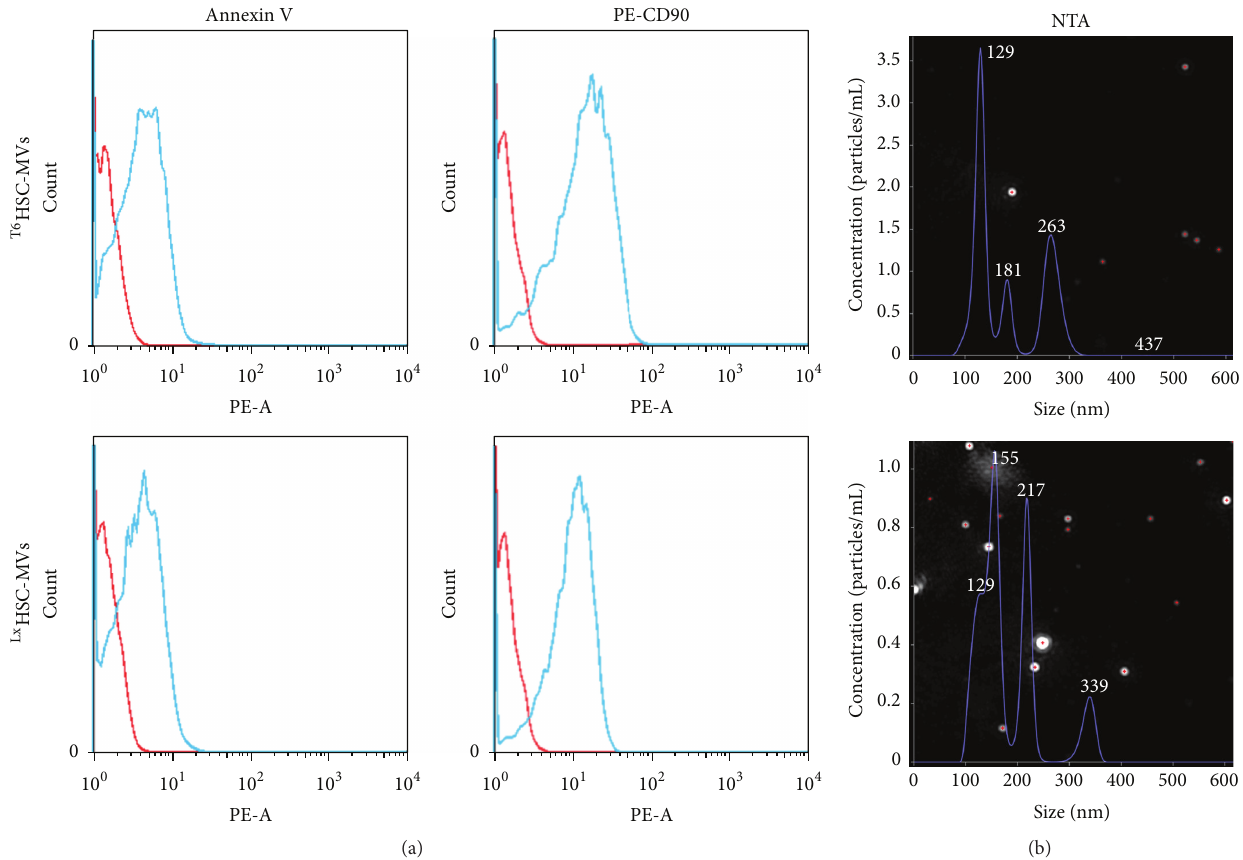
Figure 1: T6 HSC-MVs and Lx HSC-MVs separation and characterization. (a) Flow cytometric showed that HSC-MVs were specific stained with PE-CD90 and annexin V. (b) NTA analysis measured the size and amout of